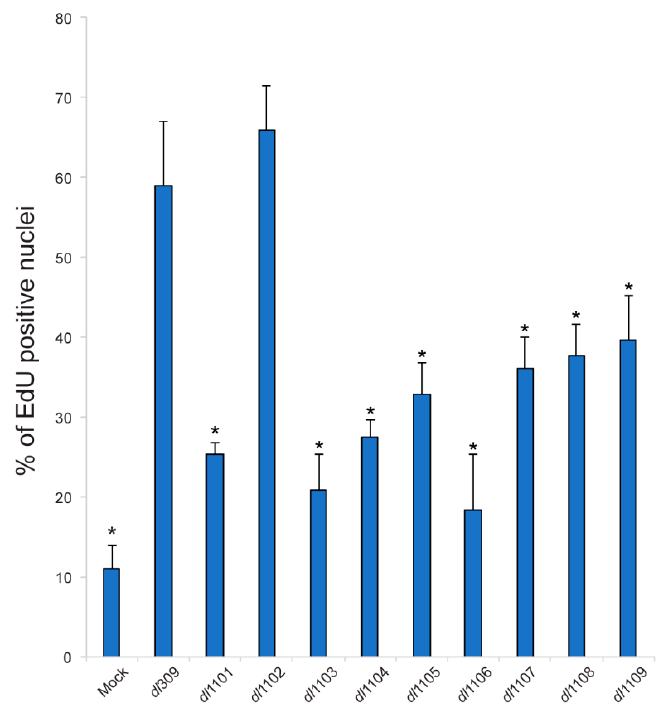
Figure 7. Induction of S-phase by E1A exon 1 mutants. WI-38 cells were grown in a four-chamber LabTek II chamber slides until confluence at which point medium was replaced and cells were incubated for 72 h before infection with the indicated viruses at a MOI of 100. At 23 h after infection, cells were pulsed for 1 h with EdU and then fixed with paraformaldehyde and stained using the Click-It EdU labeling kit for microscopy. After EdU labeling, cells were stained for E1A to mark infected cells using the M73 monoclonal antibody and Alexa 594-conjugated secondary anti-mouse antibody. DAPI was used as a nuclear counterstain. After staining, slides were mounted and imaged using Molecular Devices ImageXpress Micro 4 and analyzed using MetaXpress software. At least five independent fields of view were acquired per virus, with a minimum of 100 cells counted per field of view. Error bars represent standard deviation of five independent fields of view, asterisks represent statistically significant changes versus dl 309-infected cells with a p- value of <0.0001.